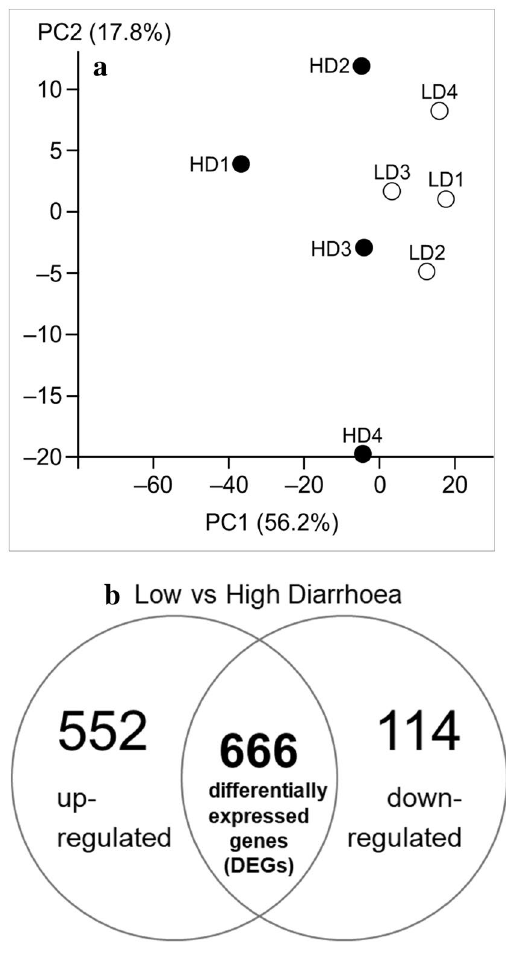
Figure 3. ( a ) PCA plot showing differences between HD and LD in gene expression. The PC1 and PC2 axes represent 56.2% and 17.8% of the total variance, respectively. ( b ) Venn-diagram presenting the total number of differentially expressed genes (DEGs), and the numbers of up- and down-regulated